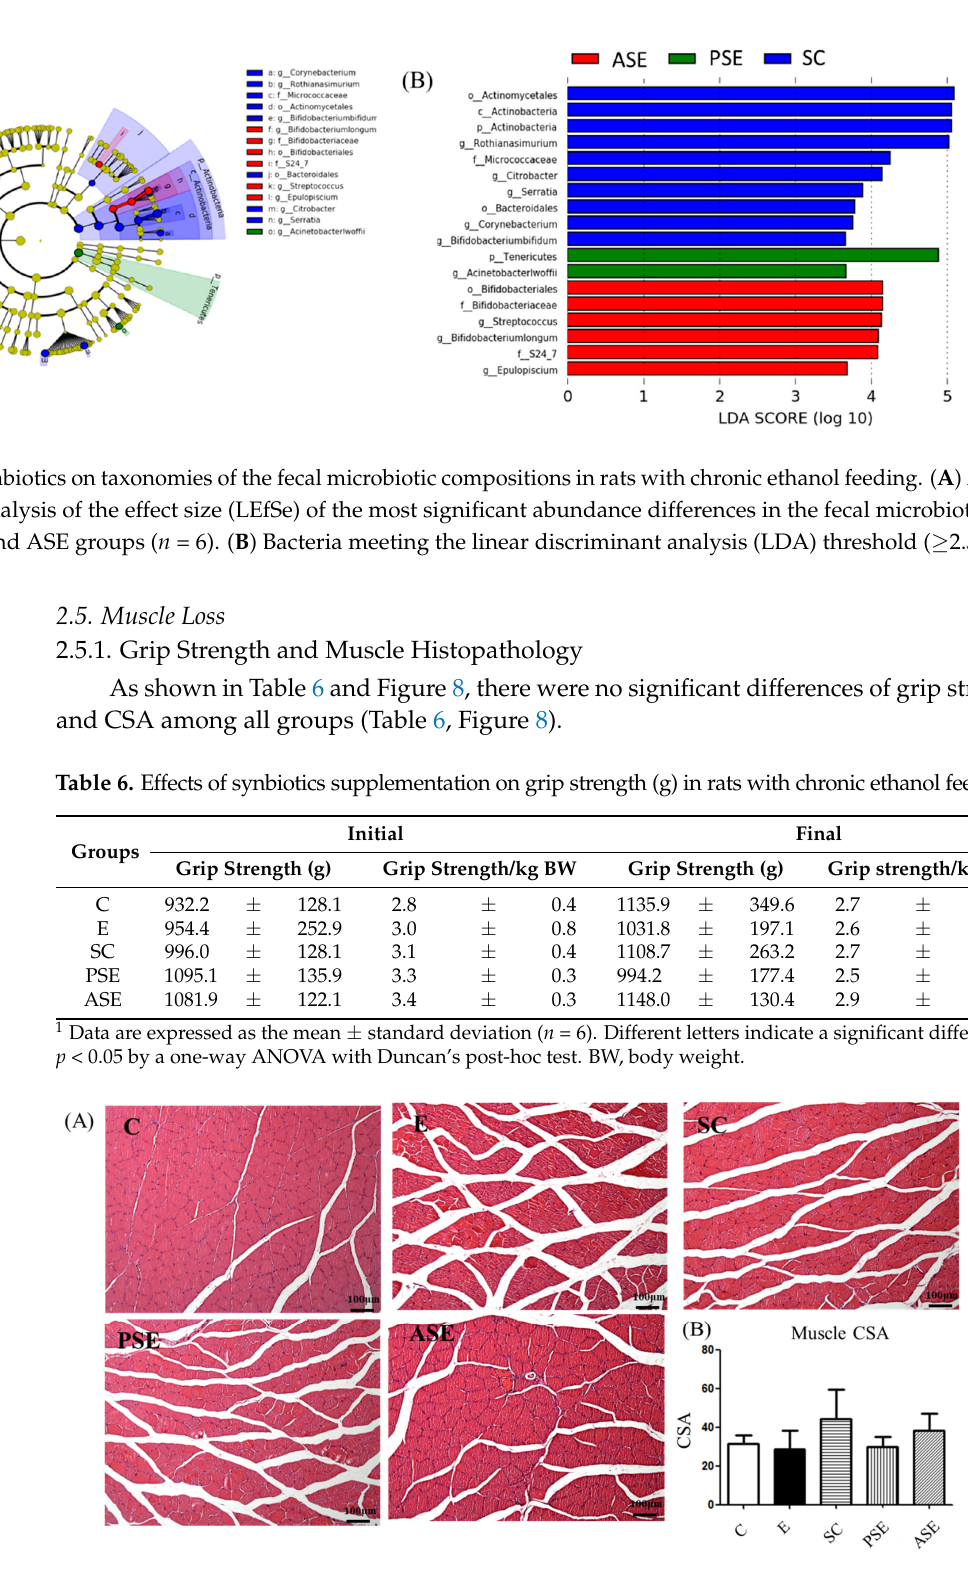
Figure 8. Effects of synbiotics on muscle cross-sectional area (CSA) in rats with chronic ethanol feeding. ( A ) H&E staining of pathological changes in the right gastrocnemius muscle. ( B ) Quantification of the area of myofibers, counted by the CSA. Bars are the mean ± standard deviation ( n = 5). Different letters indicate a significant difference at p < 0.05 by a one-way ANOVA with Duncan’s post-hoc